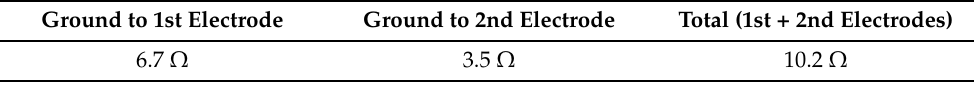
Table 1. Base resistance of the proposed